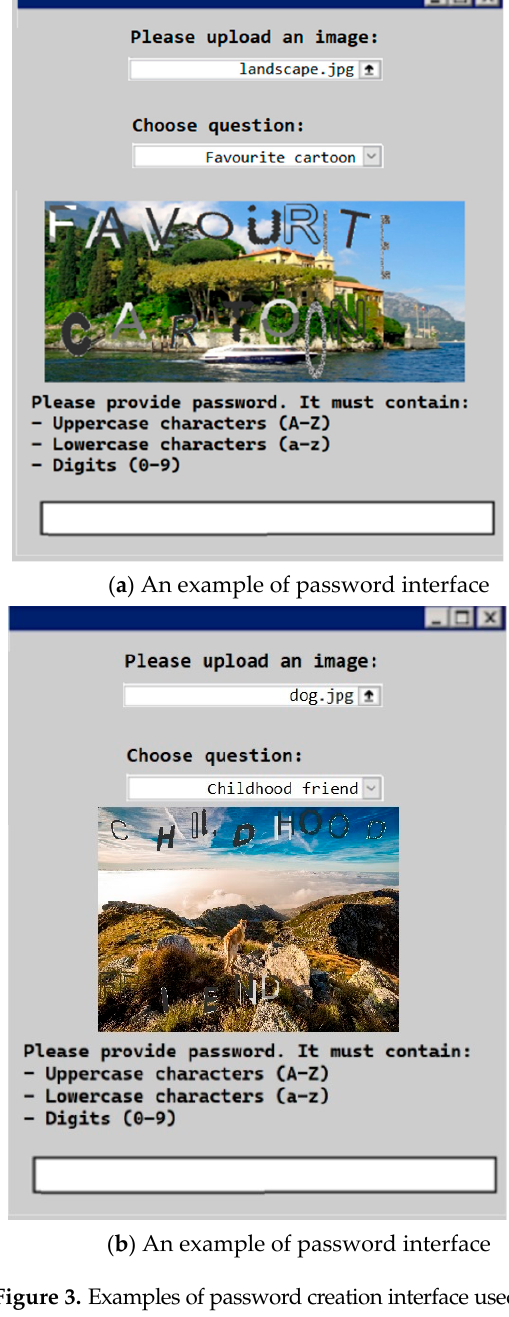
Figure 3. Examples of password creation interface used in the CAPTCHA password reminder scheme.